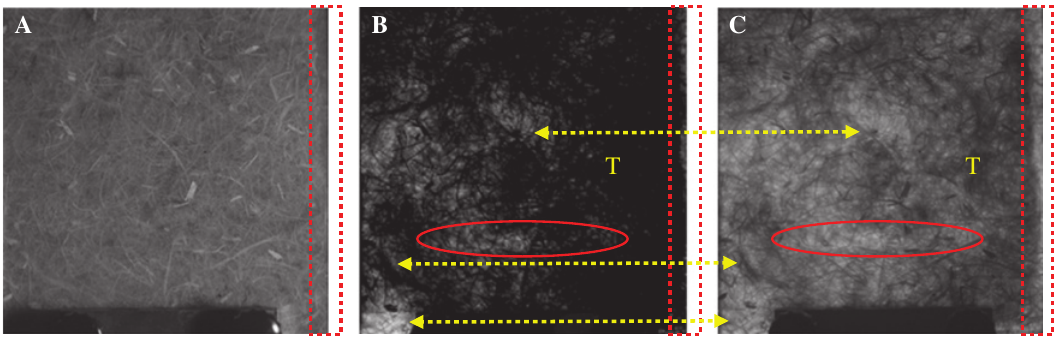
Figure 10 (A) NIR in reflection mode, (B) Image subtraction between (A) and (C), (C) NIR in transmission